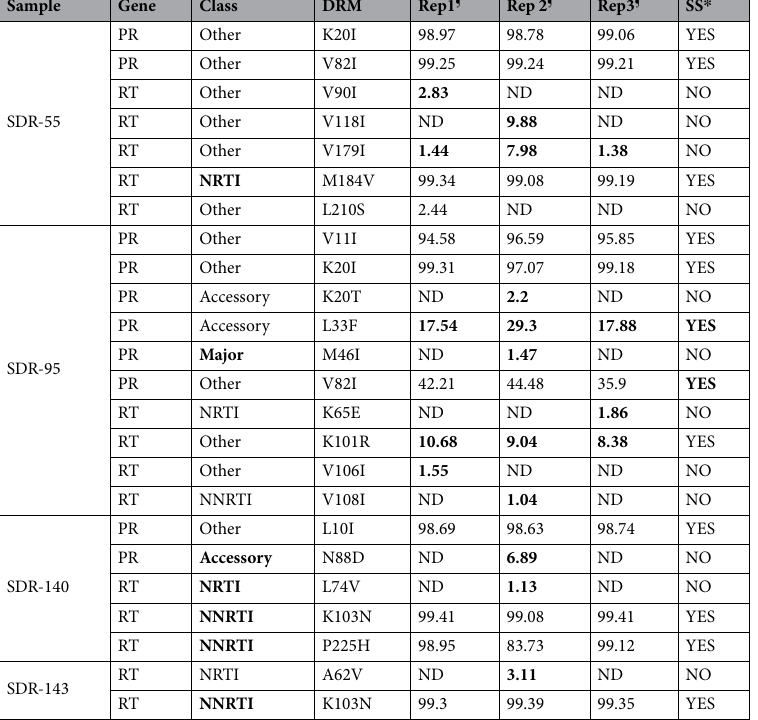
Table 4. Intra-assay precision for LADRVs identified by the MiSeq-HyDRA assay. SDRMs are highlighted in bold . ¶ Mutation frequencies (%) detected in replicates; * Detection by Sanger-based sequencing